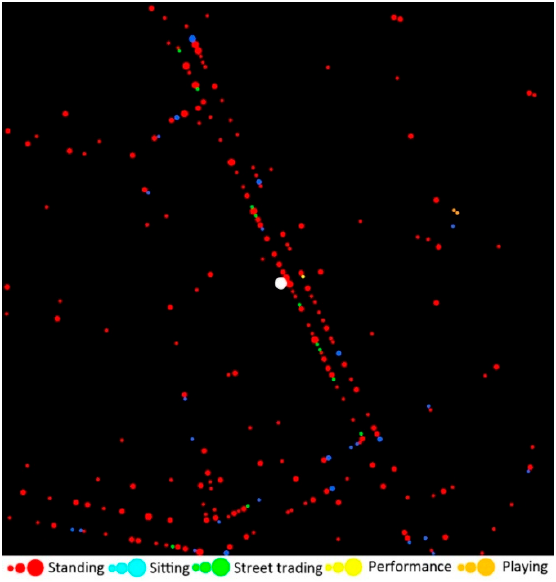
Figure 5. The mix of activities. The North: Shariati. Scale: 1 km × 1 km. Map: Nastaran Peimani.